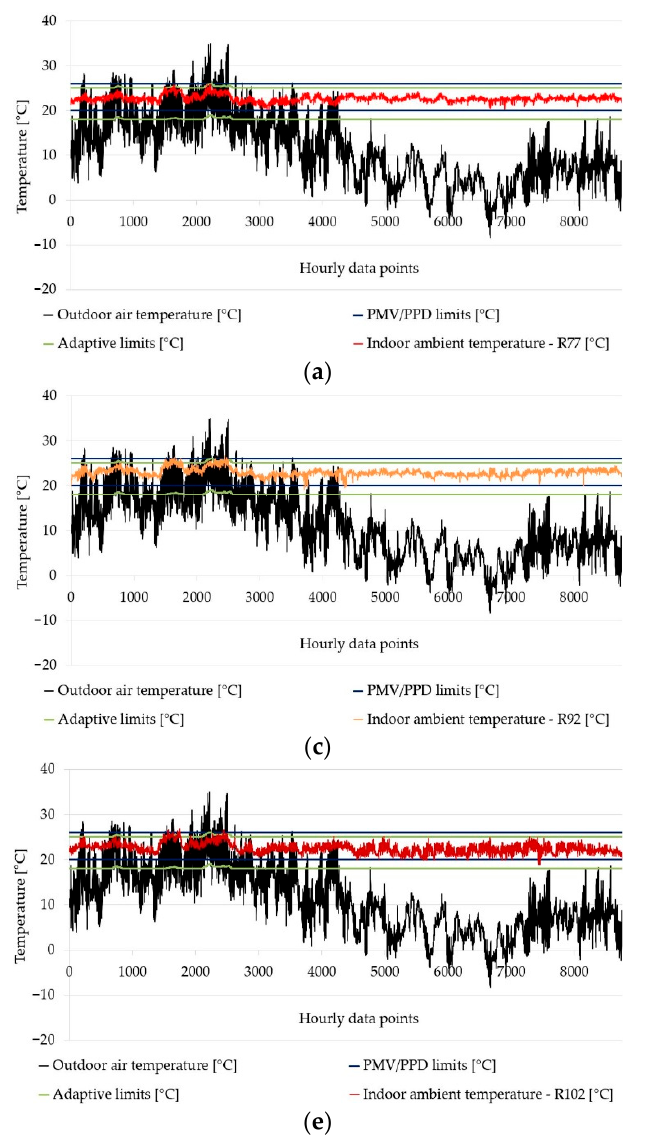
Figure 7. Hourly indoor air temperature ( ◦ C) with outdoor air temperature ( ◦ C) from May 2018 to April 2019 with PMV/PPD and adaptive category II: ( a ) R77; ( b ) R81; ( c ) R92; ( d ) R101; ( e )